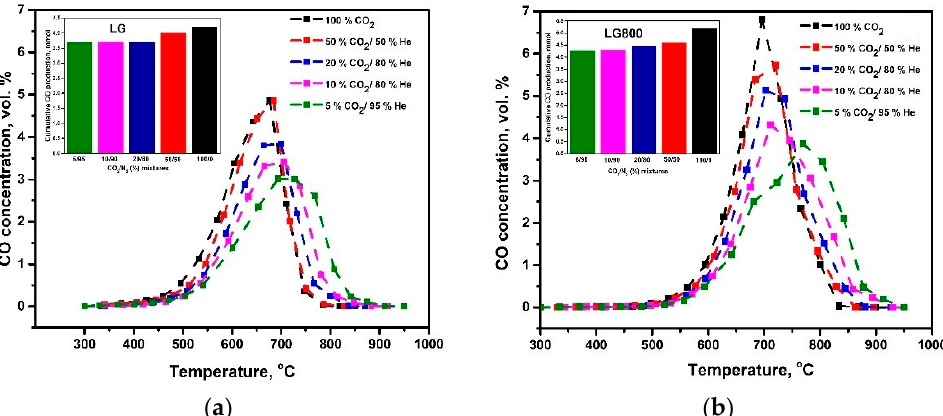
Figure 10. Effect of CO 2 feed concentration on CO evolution profiles and overall CO production (inset) for raw lignite ( a ), and LG800 ( b ) samples. Fuel: 100 mg, Flowrate: 30 cm 3 /min.